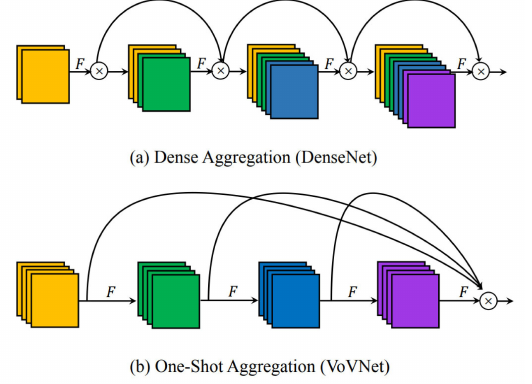
Figure 5. The structure of DenseNet and VoVNet, Z. Zheng